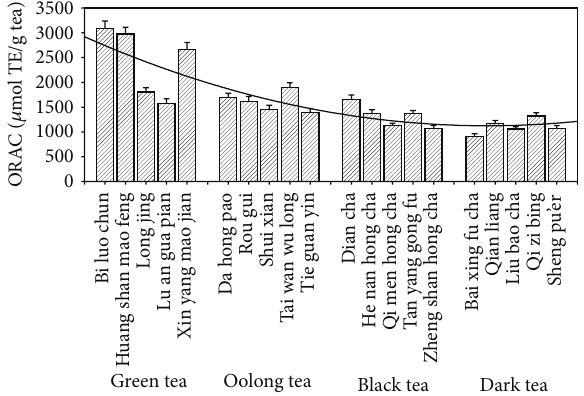
Figure 3: The correlation between total polyphenol and catechin contents.